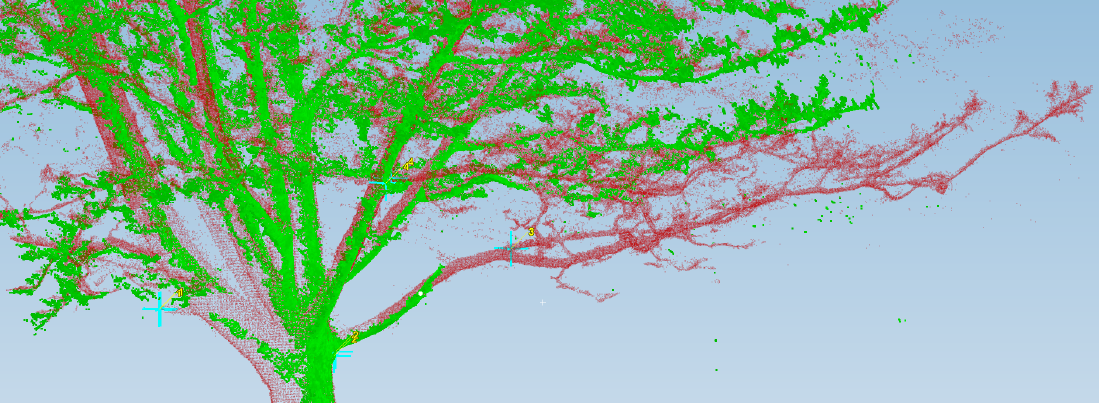
Figure 9. Co-registered maple point clouds measured in November 2012 (red) and April 2013 (green). A missing branch (31 m in total length) is clearly visible in the April 2013